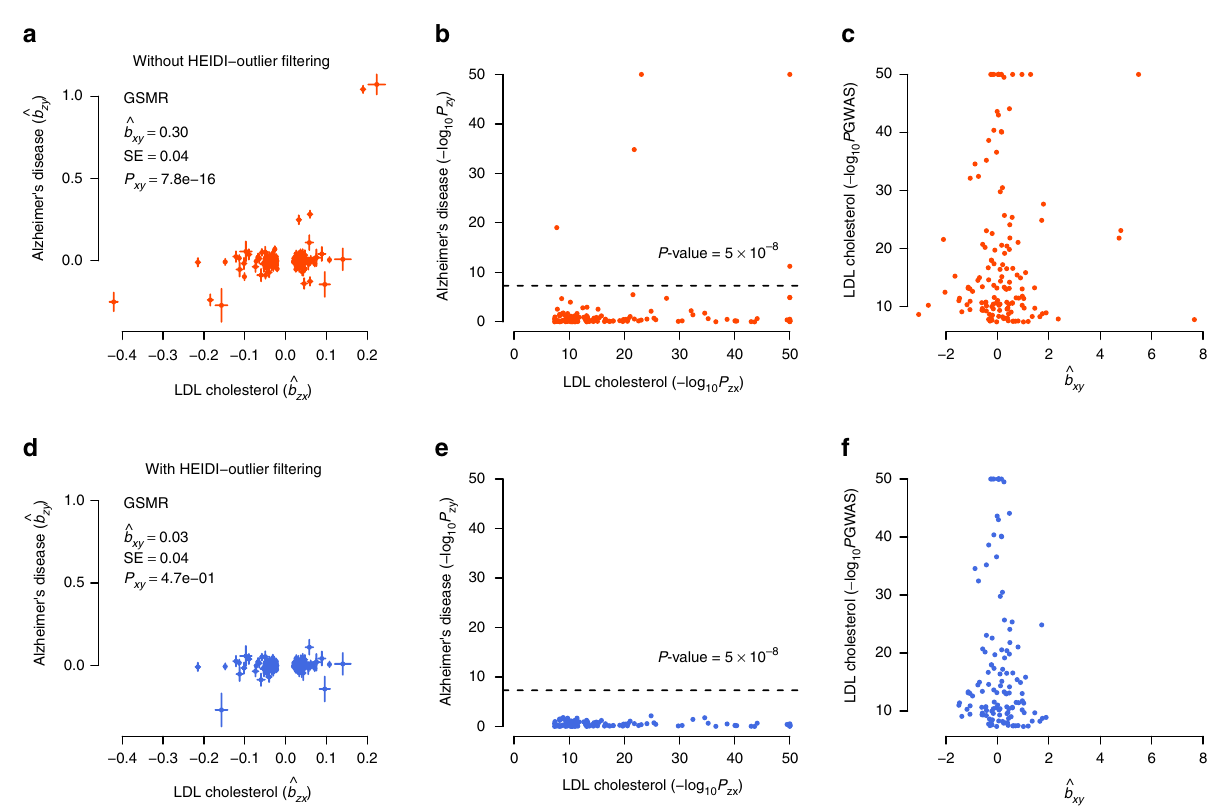
Fig. 4 GSMR analysis to test for the effect of LDL-c on Alzheimer ’ s disease (AD) with and without pleiotropic outliers. Shown in a and b are the plots of effect sizes and association P -values of the original set of instruments from GWAS for LDL-c vs. those for AD. Shown in c is the plot of b xy vs. GWAS P - value of LDL-c at each genetic variant. Shown in d , e , and f are the plots for the instruments after the pleiotropic outliers being removed by the HEIDI- outlier approach (see Methods for details of the HEIDI-outlier approach). Error bars in a and d represent the standard errors. The dashed lines in b and e represent the GWAS threshold P -value of 5 × 10 − 8 . The coordinates in b , c , e , and f are truncated at 50 for better graphic